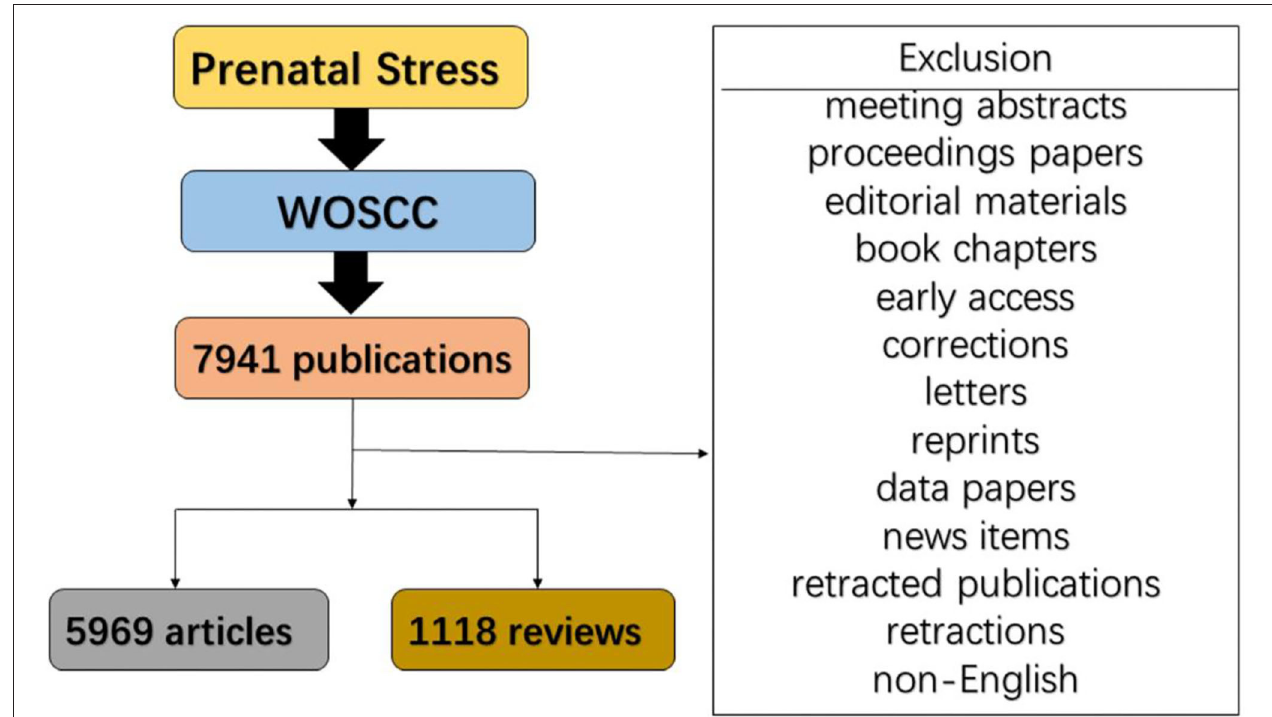
FIGURE 1 | Flowchart of the